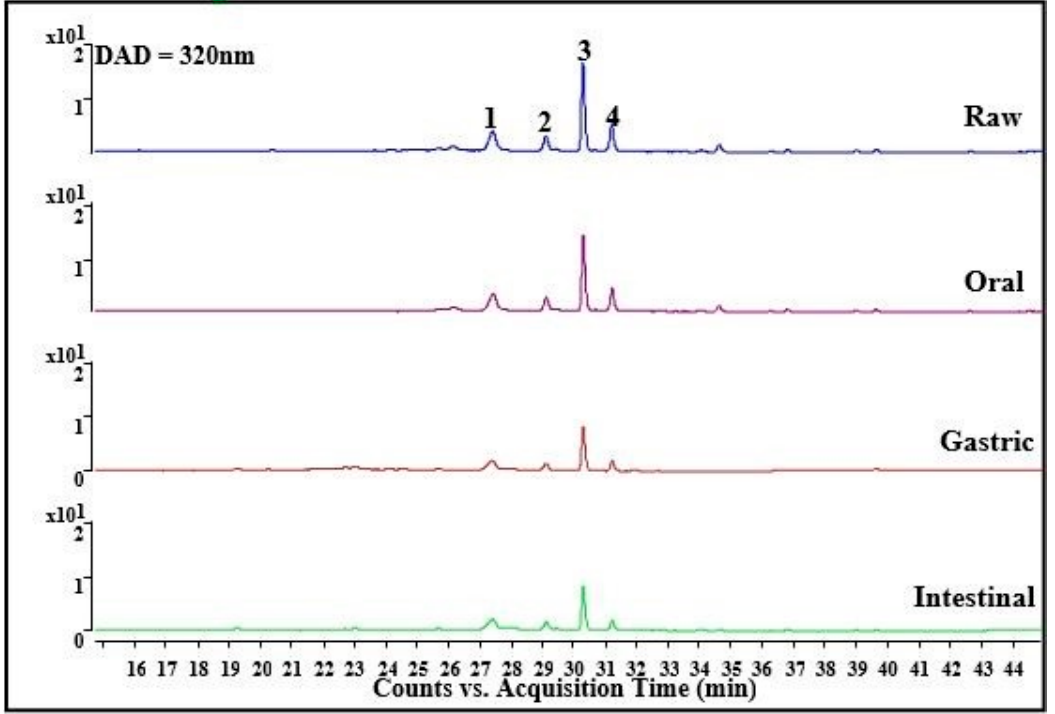
Figure 1. The change of the major phenolics in THR extract during the in vitro gastrointestinal digestion. Table 2. Identification and quantification of the major phenolics in THR extract during the in vitro gastrointestinal diges- tion and colonic fermentation by human microflora A .